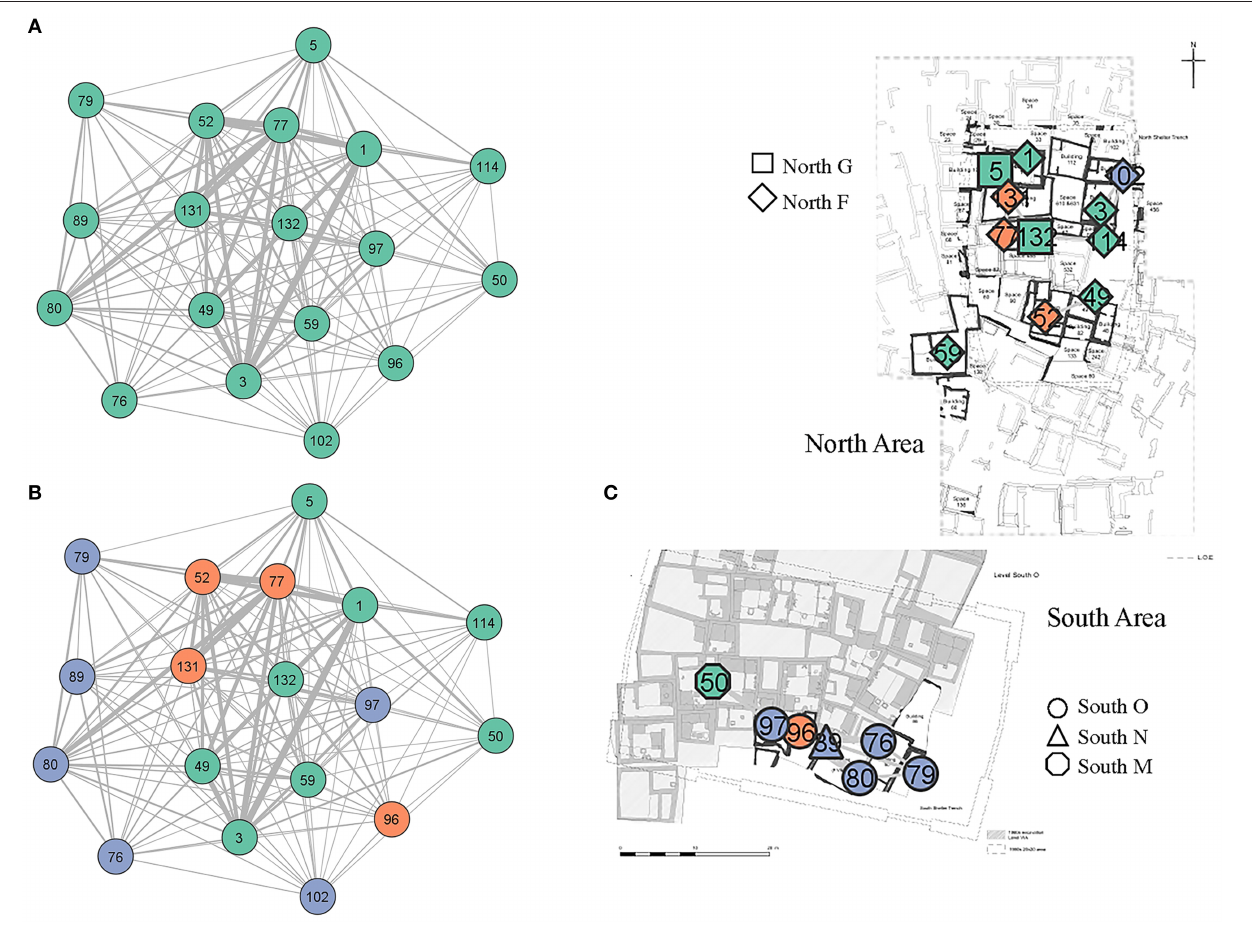
FIGURE 7 | Middle network (A) . Louvain algorithm partition (B) and middle network overlapped to the South and North Area excavation map (South O – North G) (C) .